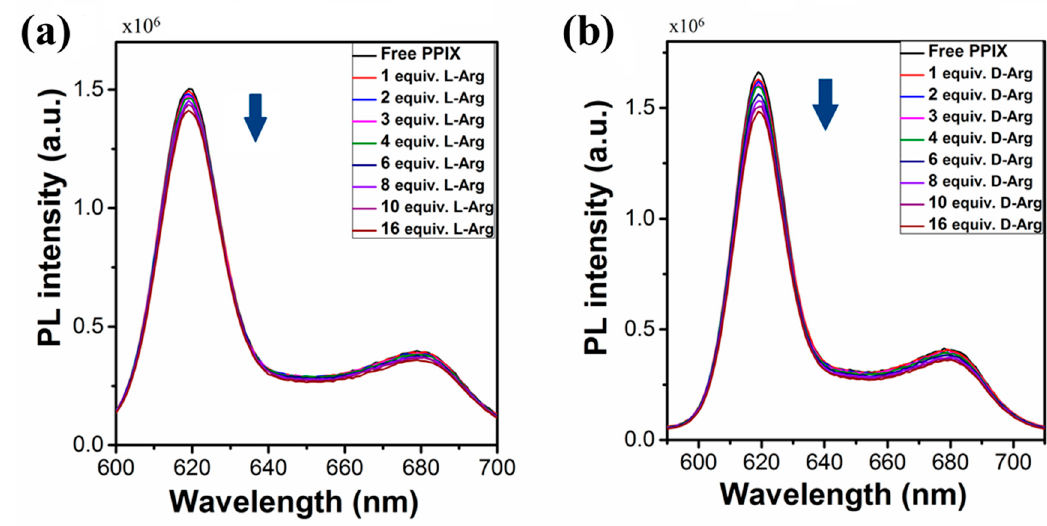
Figure 2. Changes in fluorescence emission spectra of PPIX (pH = 9) upon addition of ( a ) L - arginine and ( b ) D -arginine (0–16